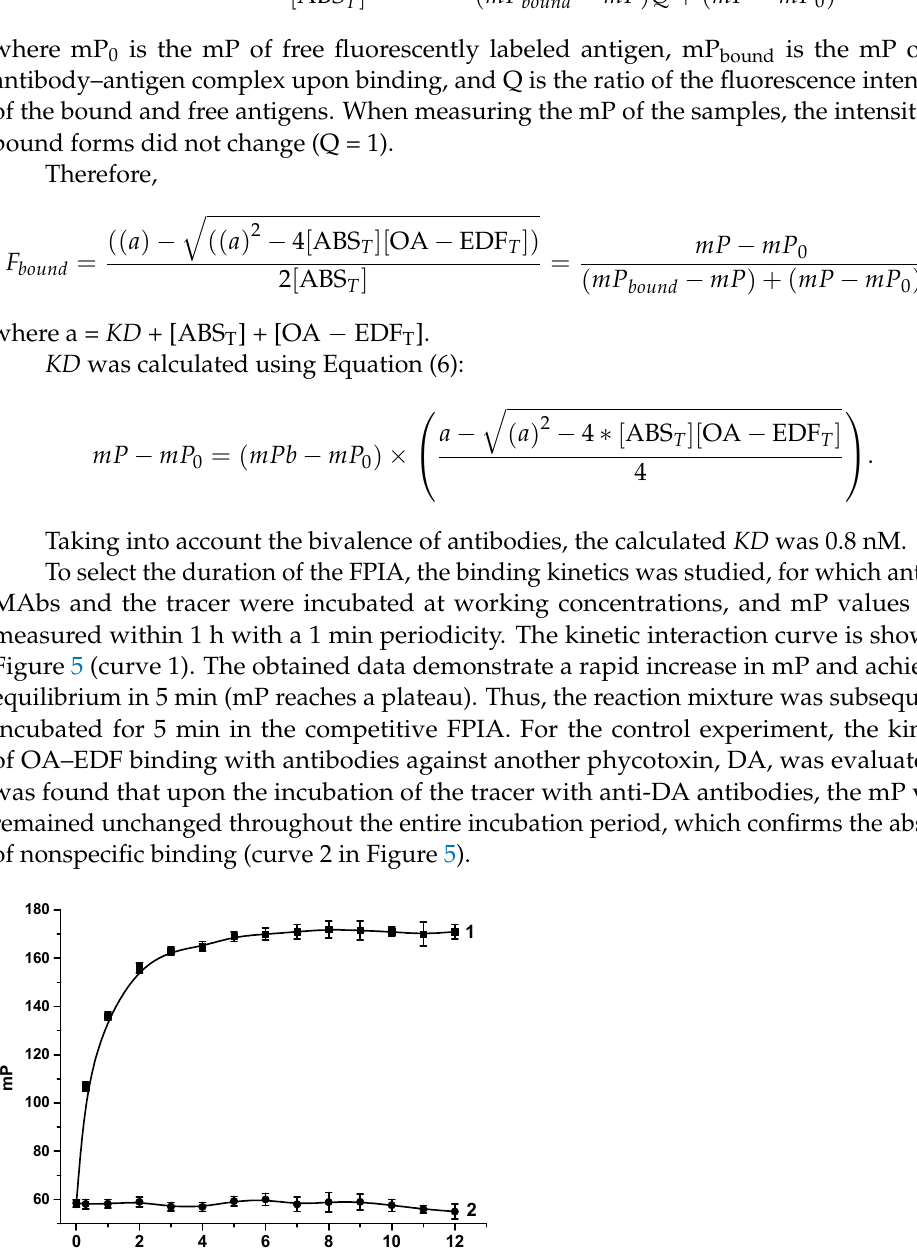
( b ) Figure 6. Calibration curve of OA in FPIA ( a ) and its linear range ( b ). Using the developed FPIA, OA concentration was determined with the LOD of 0.08 ng/mL (0.1 nM), and the working range of detectable concentrations was 0.4–72.5 ng/mL (0.5–90 nM). The duration of measurements was 5 min. 3.3. Study of the Assay Speci fi city